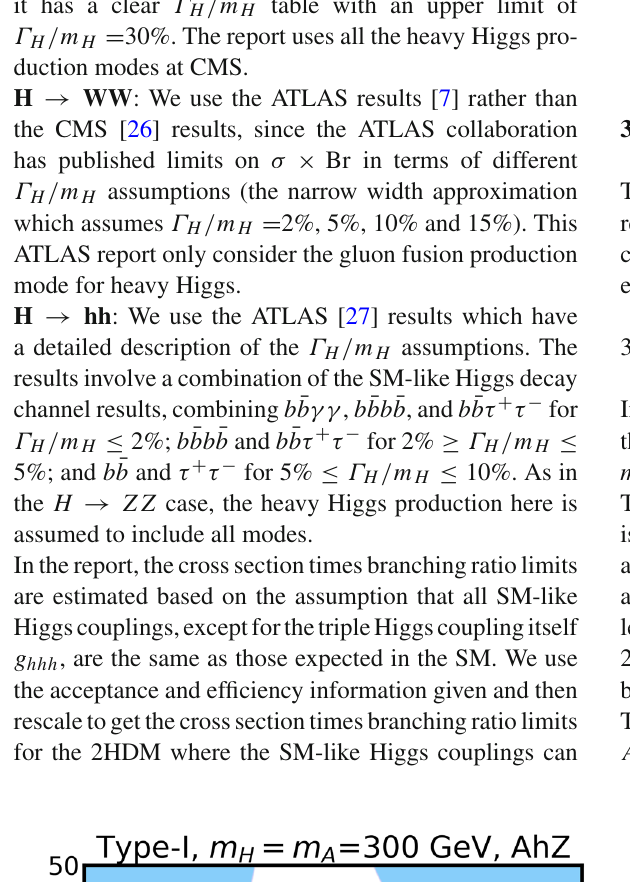
duction channel, whilst the red regions show the excluded regions by the gluon-fusion production channel. The blue backgrounds represent the points with Γ A / m A > 10% or Γ H / m H > 10% at one-loop level, which is covered by red and green regions at small tan β region. The blue regions are exactly same to them at Fig.